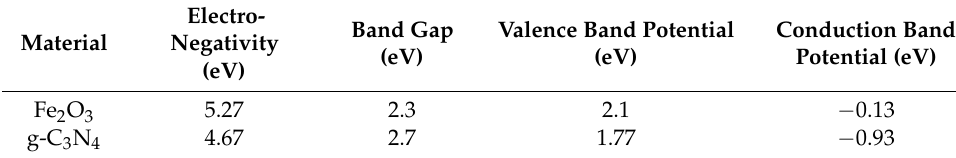
Figure 8. Possible band gaps calculated for ( a ) g-C3N4 and ( b ) Fe 2 O 3 precursors. Table 1. Band gap values calculated for g-C 3 N 4 and Fe 2 O 3 semiconducting Table 1. Band gap values calculated for g-C 3 N 4 and Fe 2 O 3 semiconducting materials.